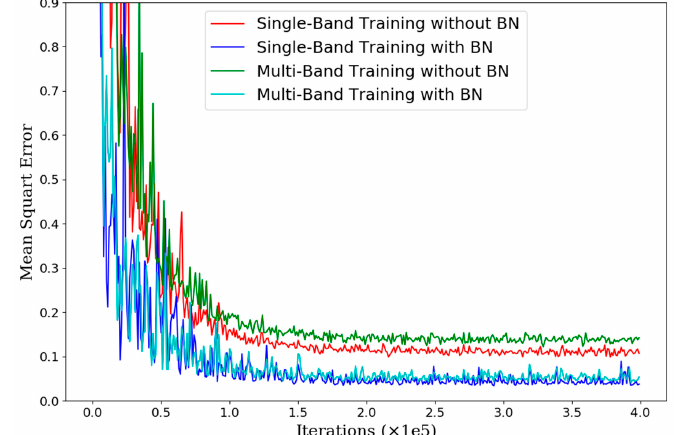
Figure 1. The convergences of the cost function during the training for the four cases: single-band training with batch normalization (BN) and without BN, and multi-band training with BN and without